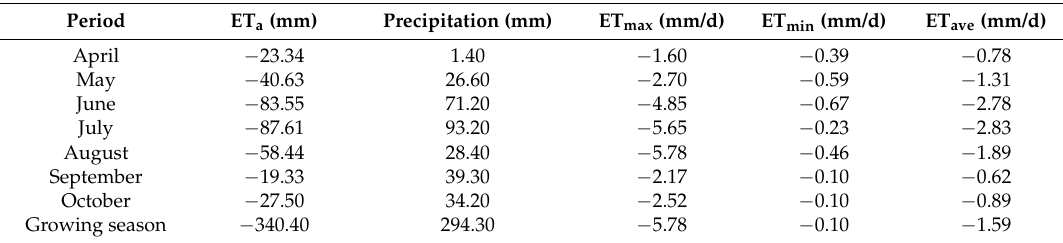
Table 5. Variations in actual evapotranspiration (ET a ) during growing season of 2016 (Additionally given is the sum ET a over the growing